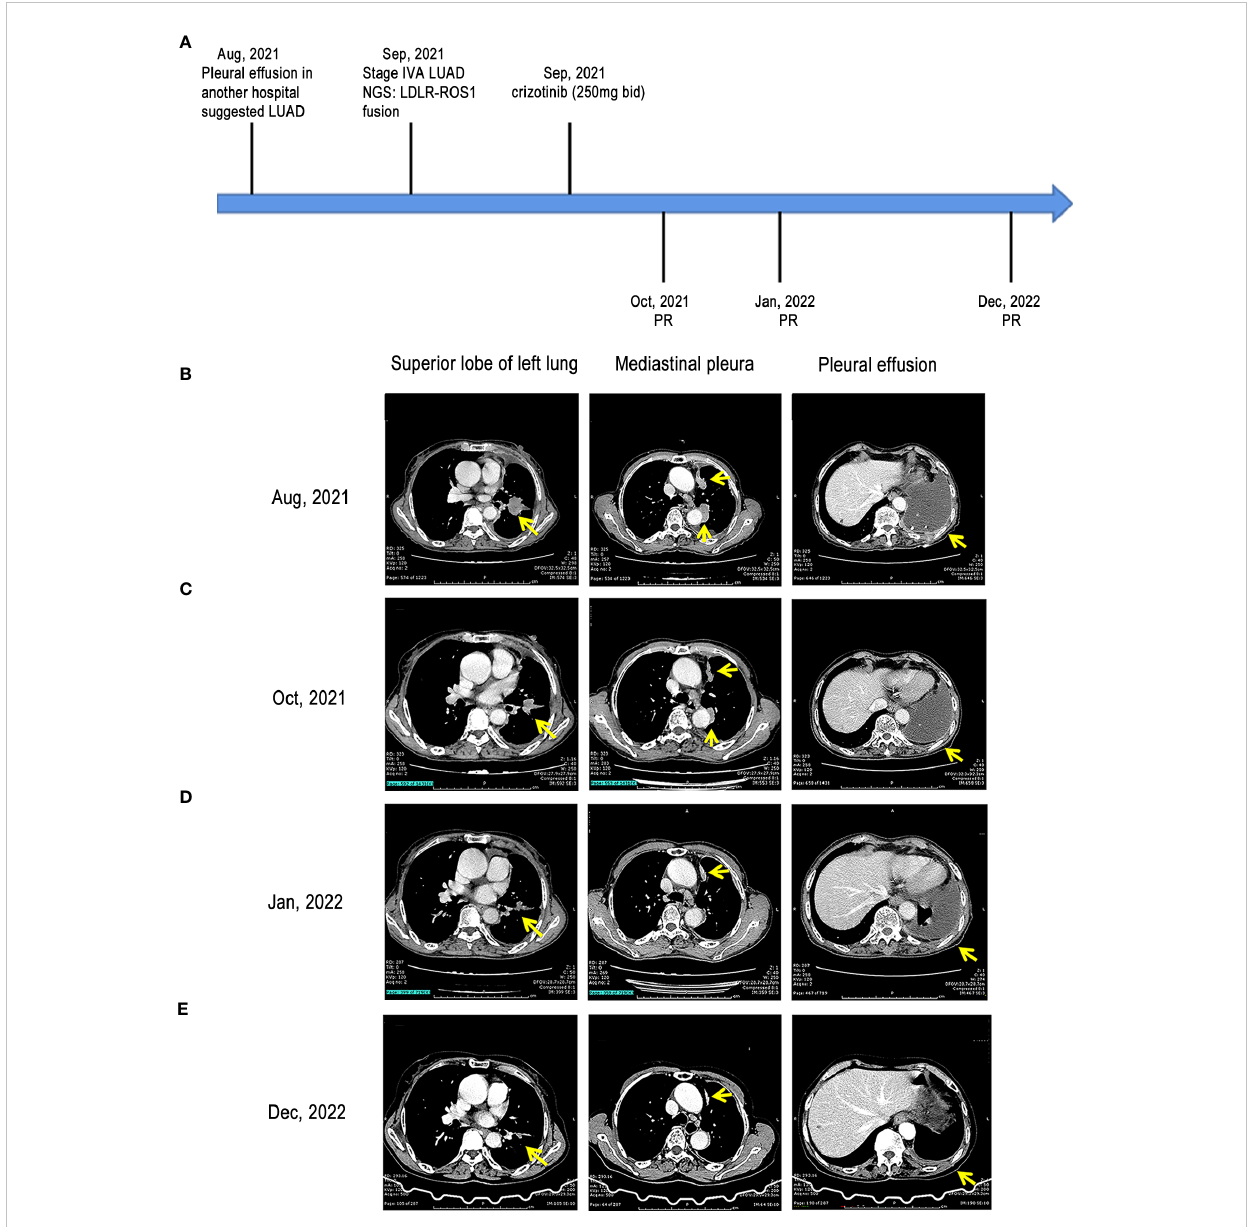
FIGURE 1 Treatment milestones of our case. (A) treatment timeline of the case; (B) CT scans of the left upper lobe mass, mediastinal pleural nodule, and pleural effusion at baseline; (C) CT scans of the left upper lobe mass, mediastinal pleural nodule, and pleural effusion at the fi rst follow-up after treatment; (D) CT scans of the left upper lobe mass, mediastinal pleural nodule, and pleural effusion at the second follow-up after treatment; (E) CT scans of the left upper lobe mass, mediastinal pleural nodule, and pleural effusion at the third follow-up after treatment LUAD, lung adenocarcinoma; CT, computed tomography; LDLR , low-density lipoprotein receptor; ROS1 , ROS proto-oncogene 1; PR, partial